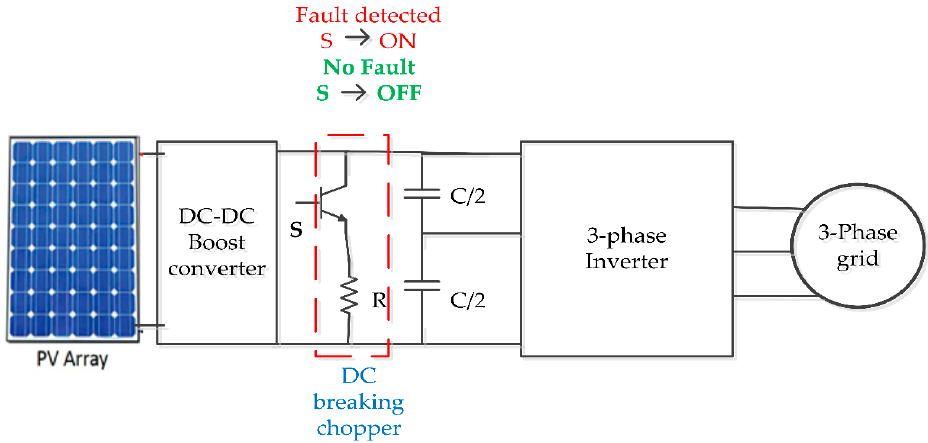
Figure 17. Solar PV system with DC-breaking chopper LVRT control scheme.